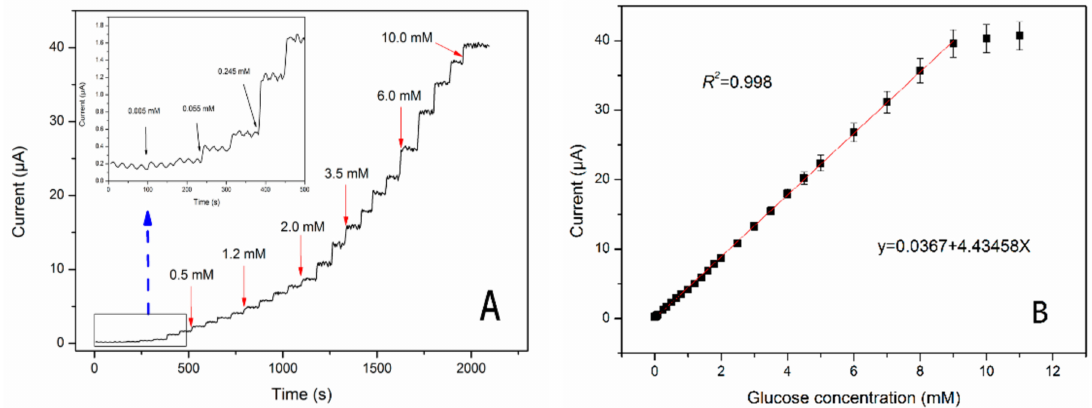
Figure 6. ( A ) Amperometric response of GOD-BLG-PtAuPd-RGO/GC electrode upon successive additions of glucose from 0.005 to 9 mM into 0.1 M pH 7.0 PBS solution under stirring at operating voltage of 600 mV; ( B ) The calibration curve between amperometric response and glucose concentration.